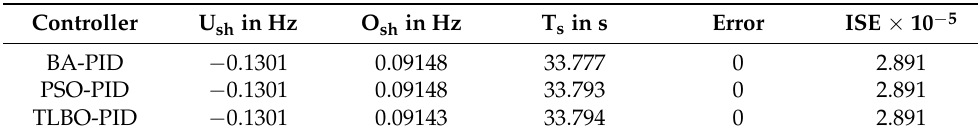
Table 7. Frequency response performances with PID tuned by different algorithms and designed by minimizing ISE.